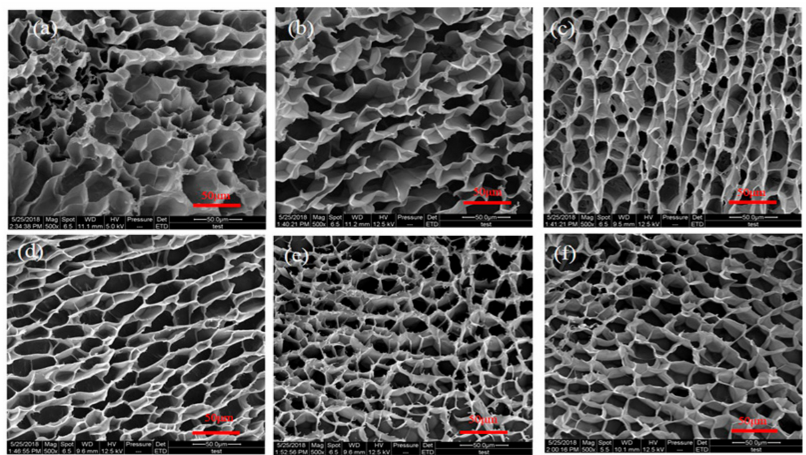
Figure 5. SEM photographs of ( a ) SAP0, ( b ) SAP3, ( c ) SAP4, ( d ) SAP5, ( e ) SAP6, and ( f ) SAP7.